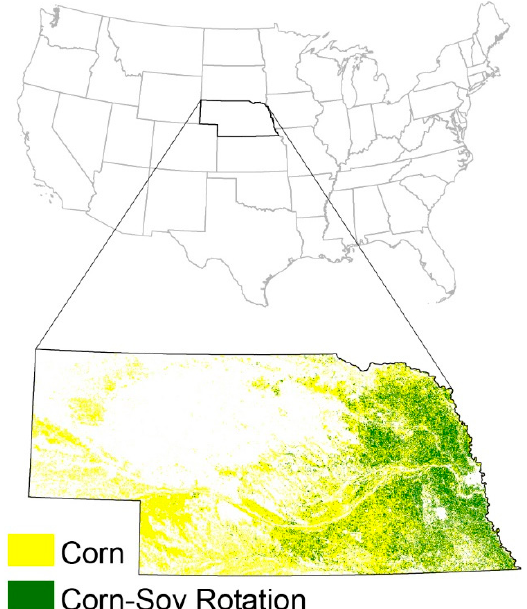
Figure 1. A map showing the location of the state of Nebraska within the continental United States, modified from USDA crop frequency maps for 2008–2017 [21]. Locations with corn grown in at least one year are shaded yellow, and locations with soy in at least five years are overlain in green. Virtually all soy in Nebraska is grown in rotation with corn.